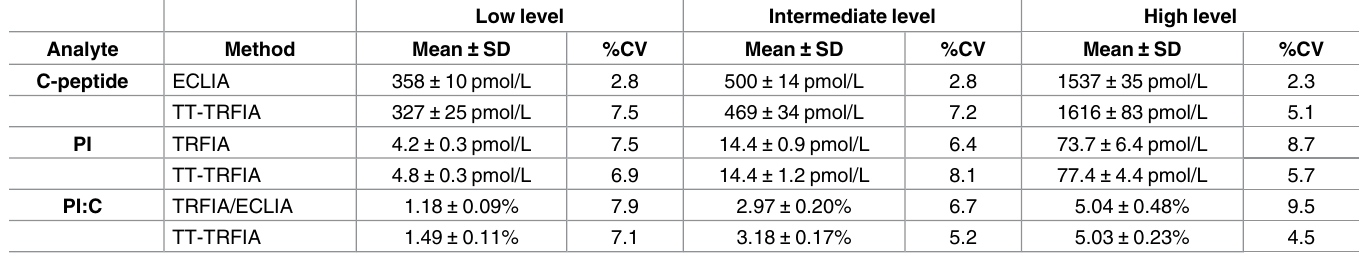
Table 1. Between-day imprecision (n = 20) of C-peptide, PI and PI:C, determined separately with two automated methods (ECLIA and TRFIA) or simultaneously with the automated TT-TRFIA in pooled human